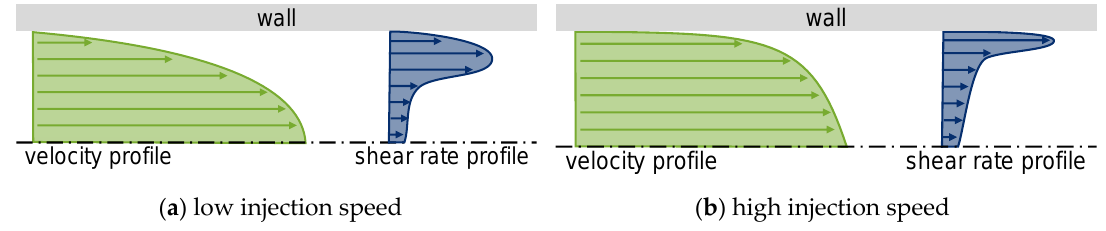
Figure 4. Influence of the injection speed on the velocity profile according to [55].